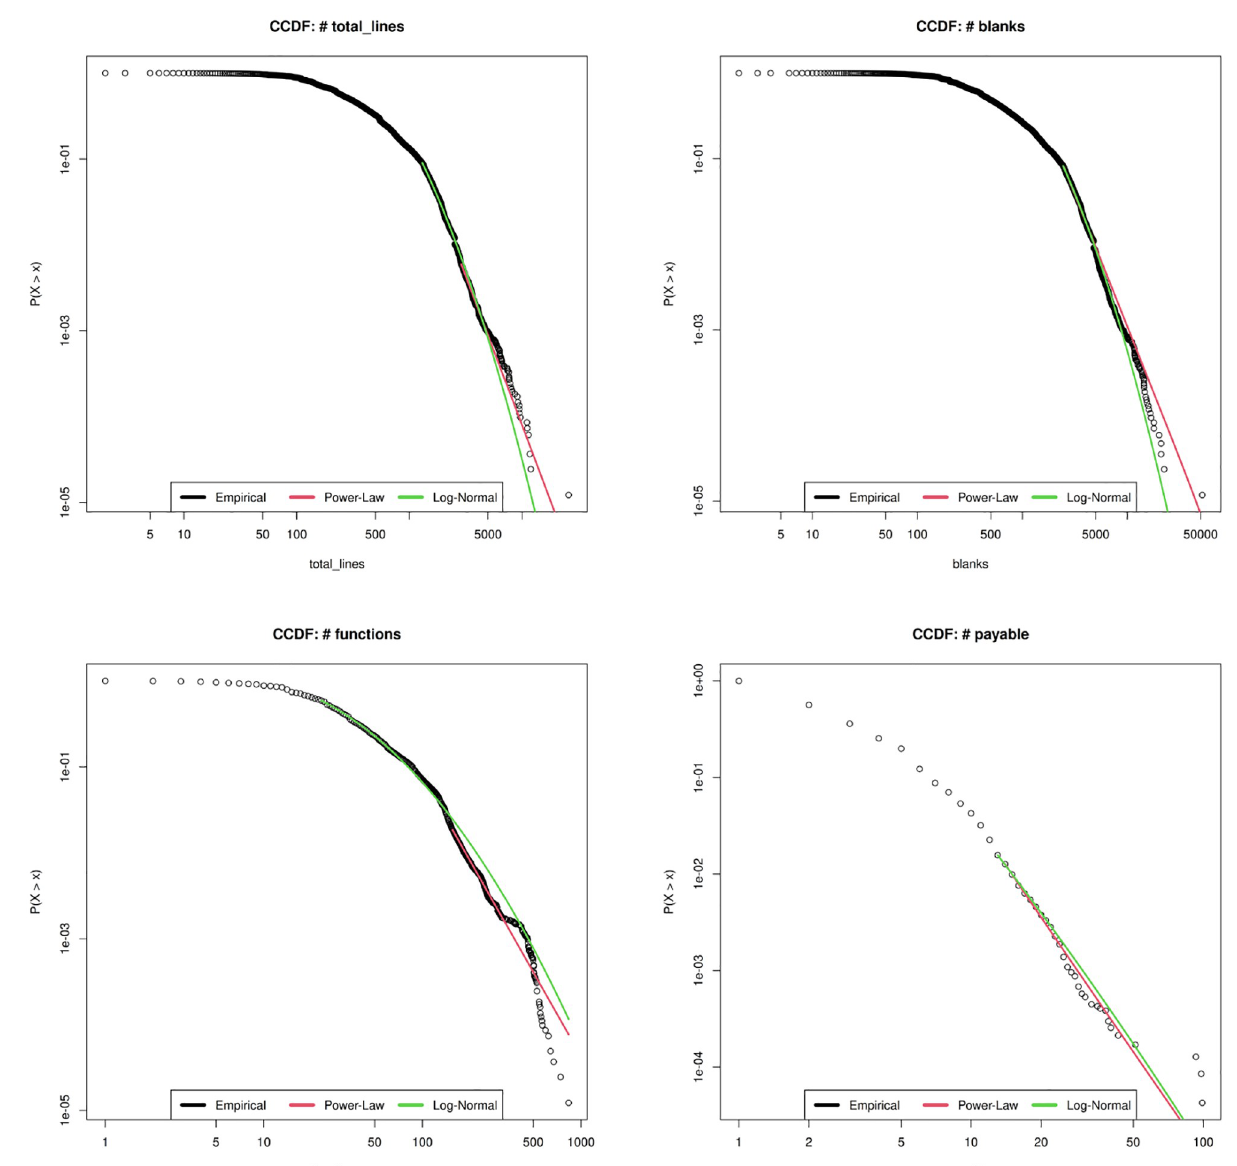
Fig 9. Power law and Log normal best fitting of the metrics Total lines, Blanks, Function and Payable.